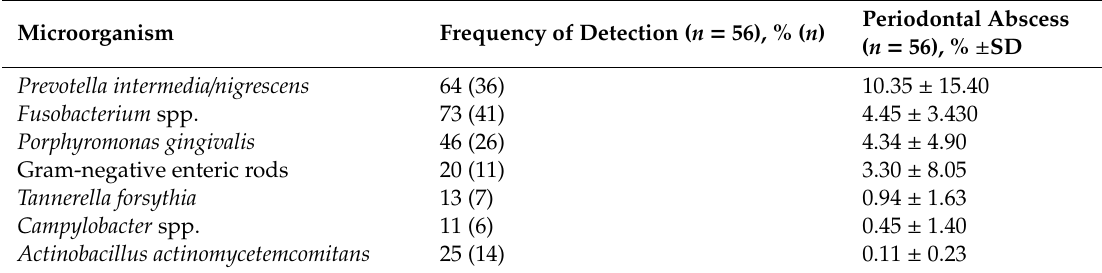
Table 3. Percentage of cultivable bacterial species in periodontal abscesses.